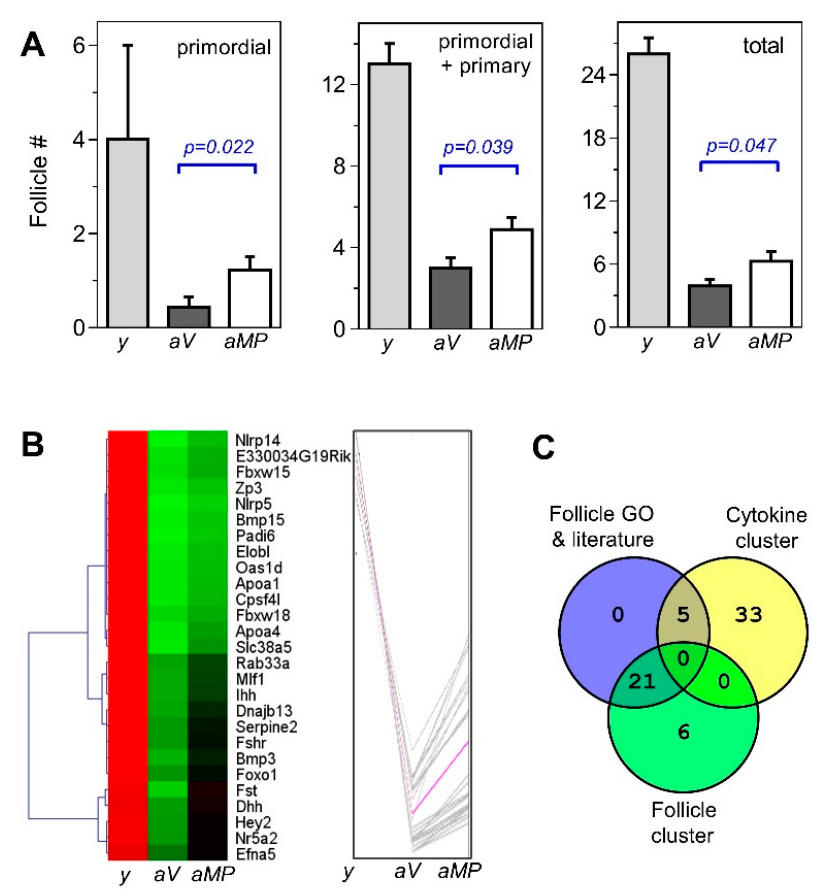
Figure 2. Ovarian follicle counts and cognate ovarian gene expression. ( A ) Mean (± standard error of the mean (SEM)) primordial, primordial plus primary, and total follicle counts in young ( y ), aged virgin ( aV ), and aged multiparous ( aMP ) ovaries; p -values are indicated. ( B ) Heatmap of the follicular-like signature (27 di ff erentially expressed genes (DEGs); rows) in ovaries of the three experimental groups ( y , aV , and aMP ) showing mean absolute levels of quantile normalized log 2 scale values. Quality threshold clustering (QTC) clustering was done with MeV (http: // mev.tm4.org / ) using the Euclidean distance and 0.42 diameter with prior gene / row adjustment divided by root mean square (RMS). The 27-genes cluster was part of the 65 DEGs of a higher expression in the multiparous ovaries (see text). ( C ) Venn diagram of the 26 follicle associated genes “Follicle GO and literature” according to gene ontology (GO) (Table 2) and literature analysis (Table 3), the 27 genes showing the follicular-like signature, “Follicle cluster”, and the 38 genes of the “Cytokine cluster” (see Section 3.6). To study the e ff ect of age and parity history on the mouse ovarian transcriptome, limma tests were conducted for the following two-group comparisons: First, young ovaries ( n = 6) versus aged ovaries irrespective of parity status ( n = 5 + 6 = 11) resulted in 905 DEGs (adj p < 0.05 and ± 1.0 log 2 FC). This comparison allowed us to interpret parity di ff erences below (Section 3.4) over an aged “baseline” gene transcription. This gene list was decomposed in 489 up-regulated and 416 down-regulated genes in aged relative to young ovaries. To our knowledge, transcriptomic studies of post-reproductive versus fertile-age human ovaries have not been reported so far. Just two proteomic studies compared pre- versus post-menopausal ovaries in small ( n = 3–4 per group) sample sizes (Table 1). Moreover, neither a single-gene nor transcriptomic parity-dependent gene expression study has been previously addressed in the human postmenopausal